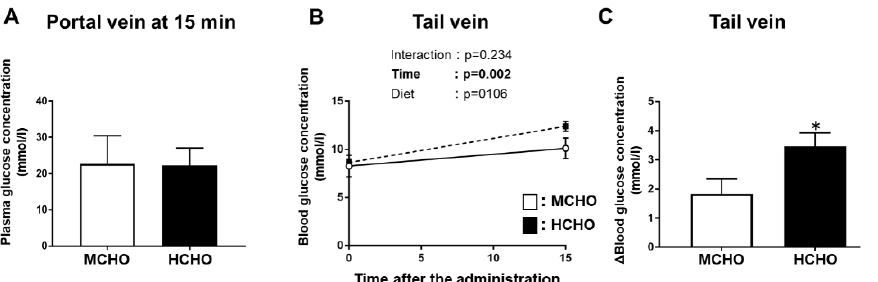
Figure 7. Glucose concentrations in blood obtained from the ( A ) portal vein or ( B ) tail vein after the post-exercise oral administration of the glucose solution in the mice fed the HCHO (black) or MCHO (white) diet for 10 days (n = 7–9). ( C ) Differences in tail-vein blood glucose concentrations between immediately after exercise and 15 min after glucose administration. Values are mean ± SE. * p < 0.01 vs. MCHO group.